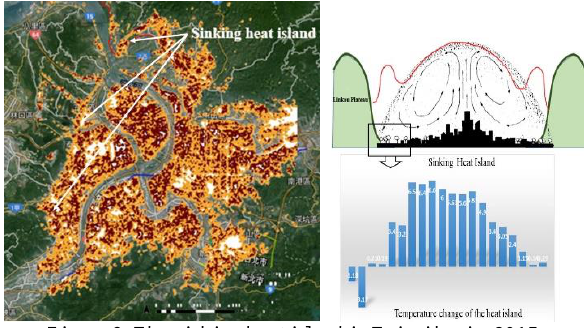
Figure 6. The sinking heat island in Taipei basin, 2015. Figure 7 reflects the difference of heat island temperature between 2000 and 1990. The counterpart for 2015 and 2000 is concluded in Figure